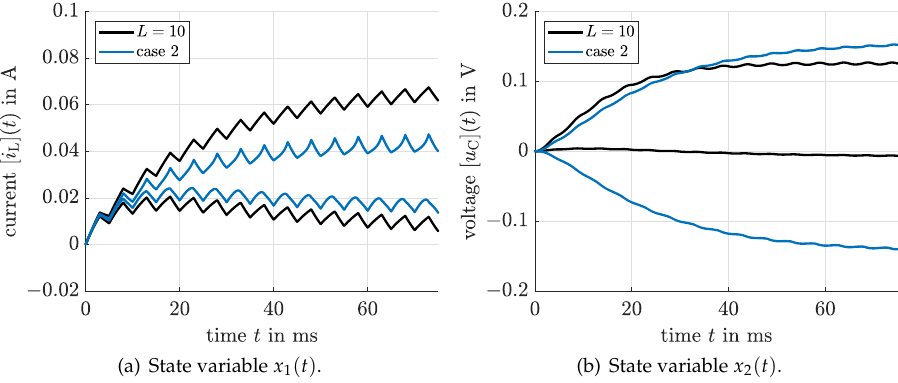
Figure 7. Comparison of the proposed approach with L = 10 with the results of verifyode for the case 2 .